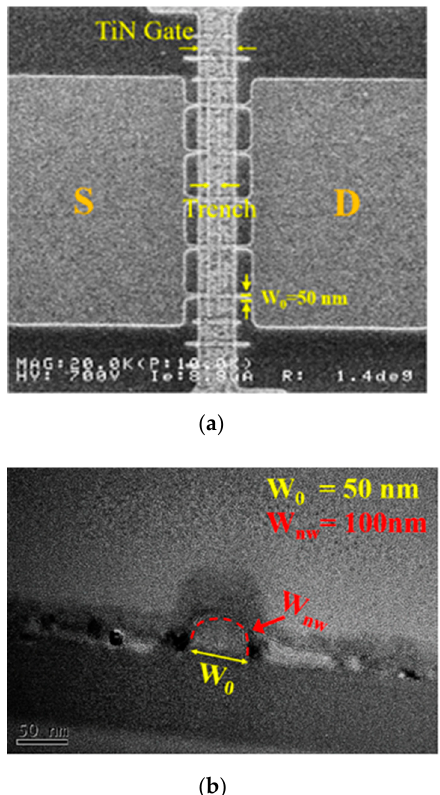
Figure 3. ( a ) Top-view SEM images of the JL FinTFT with L g = 200 nm. ( b ) TEM image of a single NW along A–A’ direction.